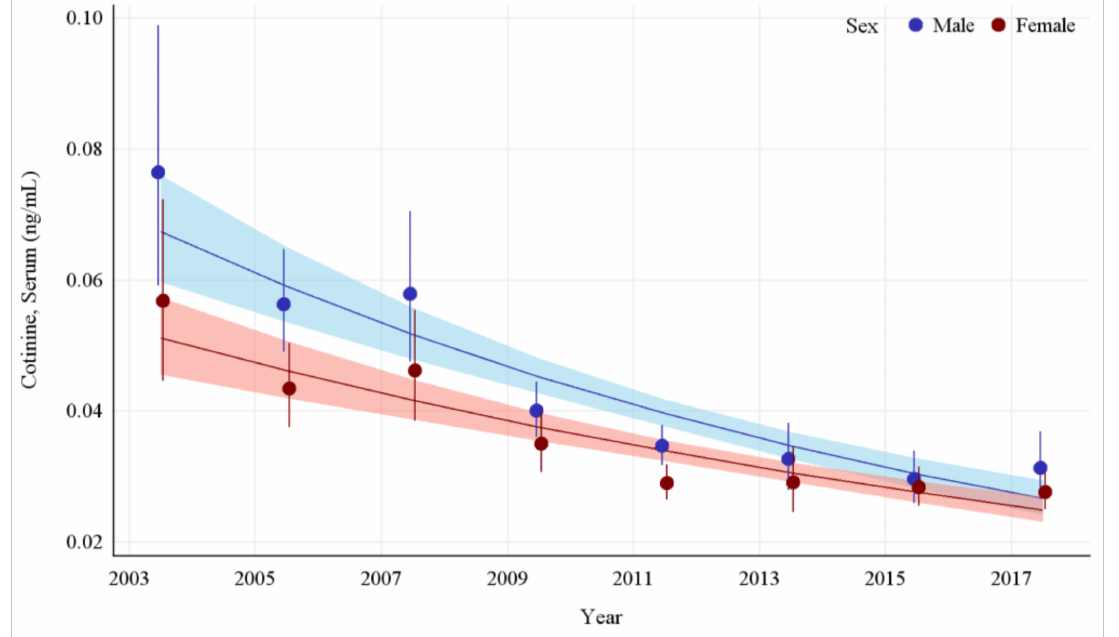
Figure 4. Sample-weighted geometric means (GM) and 95% confidence intervals (CI) of serum cotinine for U.S. nonsmokers aged ≥ 3 years by sex from 2003 to 2018. The data are plotted at the approximate midpoint of each study interval for eight separate NHANES survey cycles. The points represent the GMs and the vertical lines represent 95% CIs of the GMs for each survey cycle. Data points for each group within the same NHANES survey have been slightly offset to more easily visualize overlapping 95% CIs. The dark trend lines represent the weighted log-linear regression lines for each sex and the corresponding shaded areas are the 95% CIs of the regression